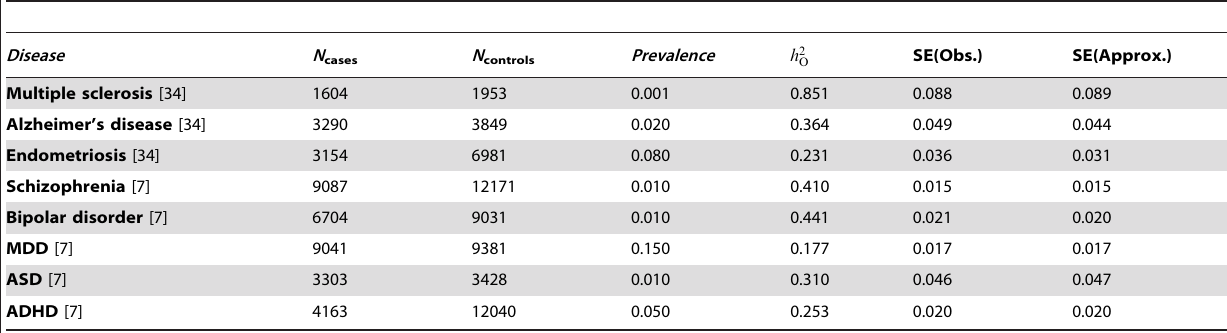
Table 2. Standard errors of the estimates of variance explained by all SNPs on the observed scale ( h 2 case-control studies for a number of diseases vs. those predicted from the approximation theory.